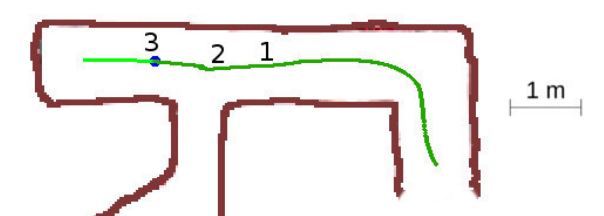
Figure 15. Unexplored three-way crossing